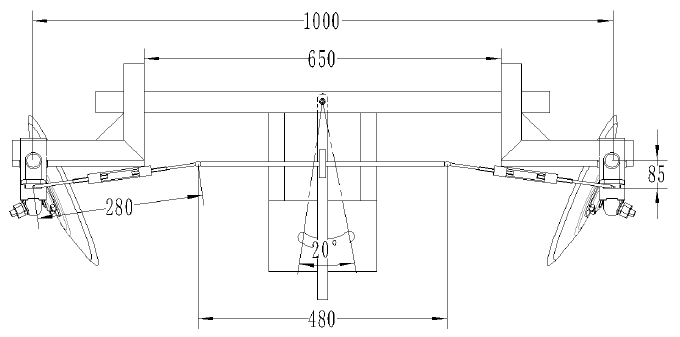
Figure 5. The size of adjusting mechanism.